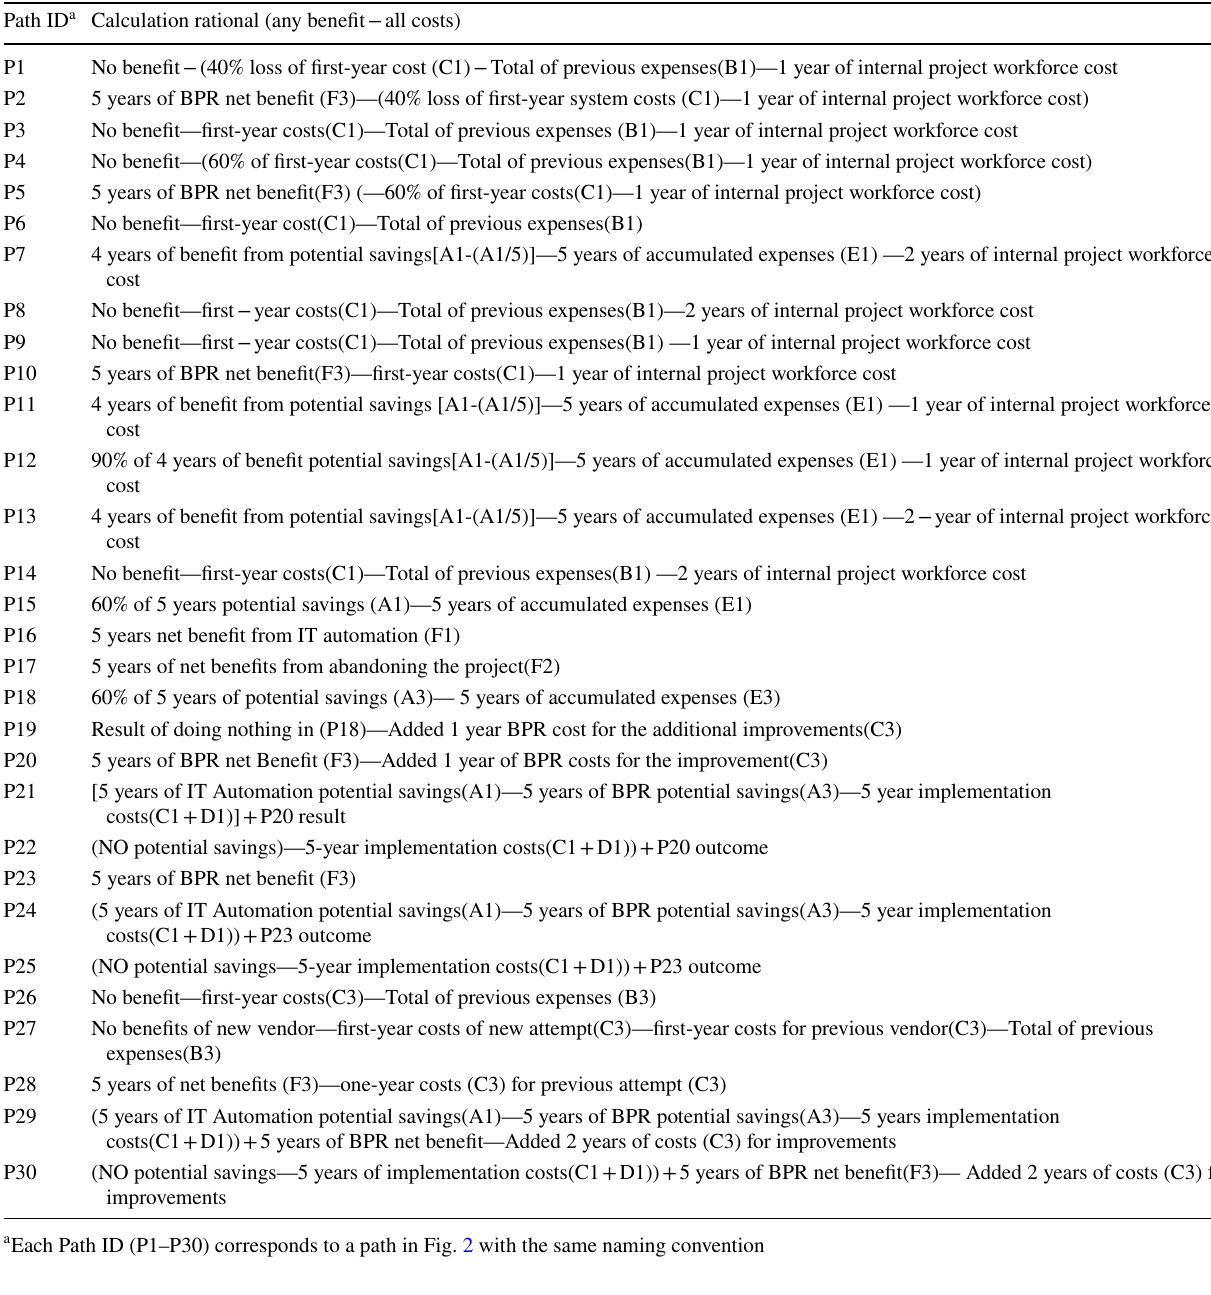
Table 8 Estimating cost ‒ benefit (CB) values for each outcome in each path